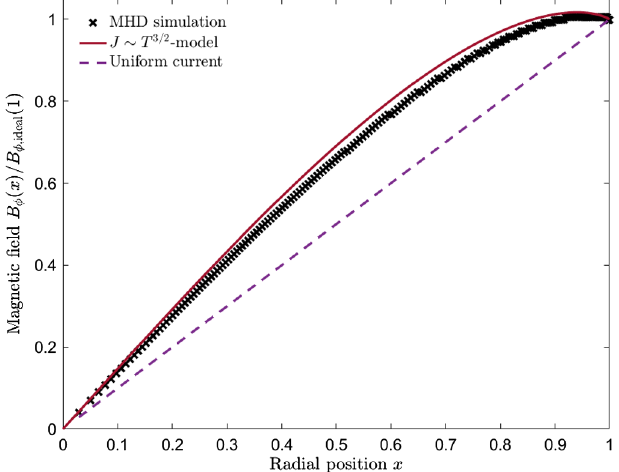
FIG. 1. MHD simulation results for a R ¼ 0 . 5 mm gas column with I 0 ¼ 364 A. The J ∼ T 3 = 2 -model is of the form of Eq.